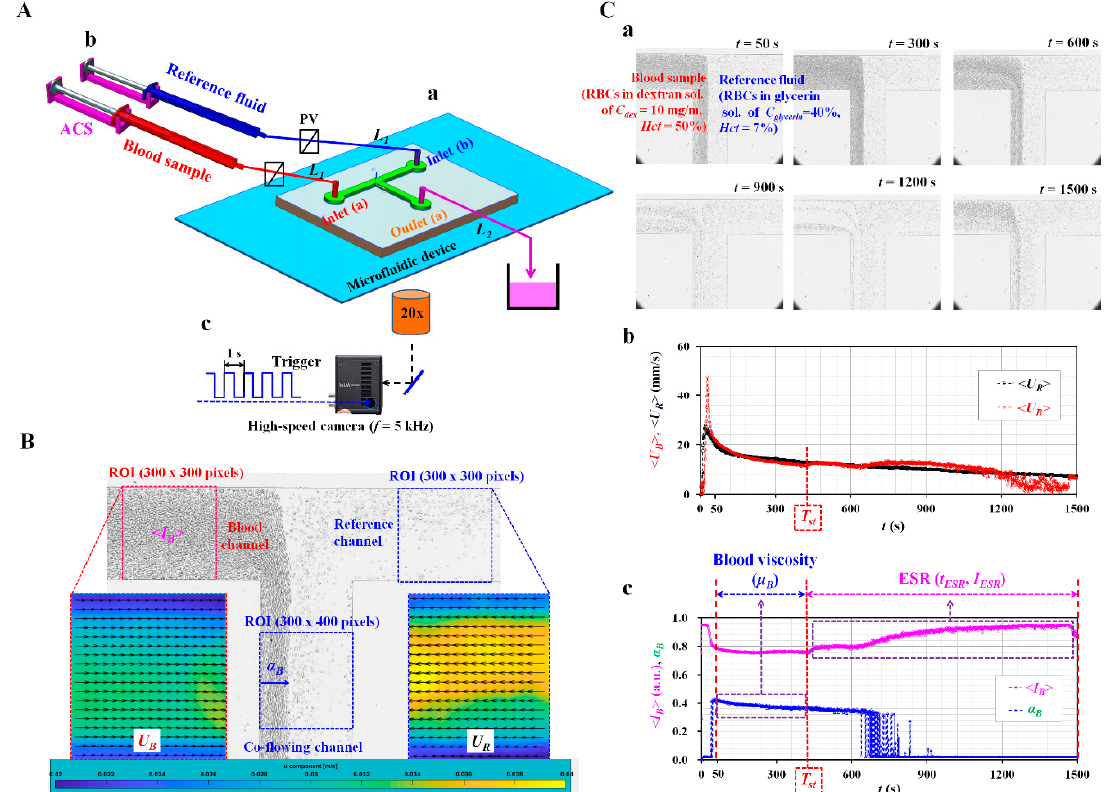
Figure 1. Proposed method for measuring blood viscosity and erythrocyte sedimentation rate (ESR) under fluid delivery of two air-compressed syringes (ACSs). ( A ) Schematic diagram of the proposed technique, including a microfluidic device, two ACSs, and an image acquisition system. ( a ) A microfluidic device consisting of two inlets ( a , b ), one outlet ( a ), and a T-shaped channel (i.e., blood channel, reference channel, and co-flowing channel). ( b ) Two ACSs for delivering blood samples and reference fluid. Each ACS was composed of a disposable syringe (~1 mL), a fixture, and a pinch valve. ( c ) The microfluidic device is located in an optical image acquisition system composed of optical microscopy with a 20 × objective lens (NA = 0.4), and a high-speed camera. The camera had a frame rate of 5 kHz and captured sequential snapshots at an interval of 1 s. ( B ) Three regions-of-interest (ROIs) were selected for evaluating four parameters ( < I B > , U B , U R , and α B ). < I B > and α B were obtained by conducting digital image processing. U B and U R were obtained by conducting a micro-particle image velocimetry (PIV) technique. ( C ) As a preliminary demonstration, blood sample (normal RBCs in 10 mg / mL dextran solution ( Hct = 50%)) and reference fluid (RBCs in 40% glycerin solution ( Hct = 7%)) were delivered to each inlet with two ACSs. ( a ) Microscopic images captured at a specific time ( t ) ( t = 50, 300, 600, 900, 1200, and 1500 s). ( b ) Temporal variations of < U B > and < U R > . ( c ) Temporal variations of < I B > and α B . Separation time ( T st ) was obtained as the time when < I B > started to increase. First, blood viscosity was evaluated from three parameters ( U B , U R , and α B ) obtained within T st . Second, the ESR of the blood sample was evaluated from < I B > obtained above T st .